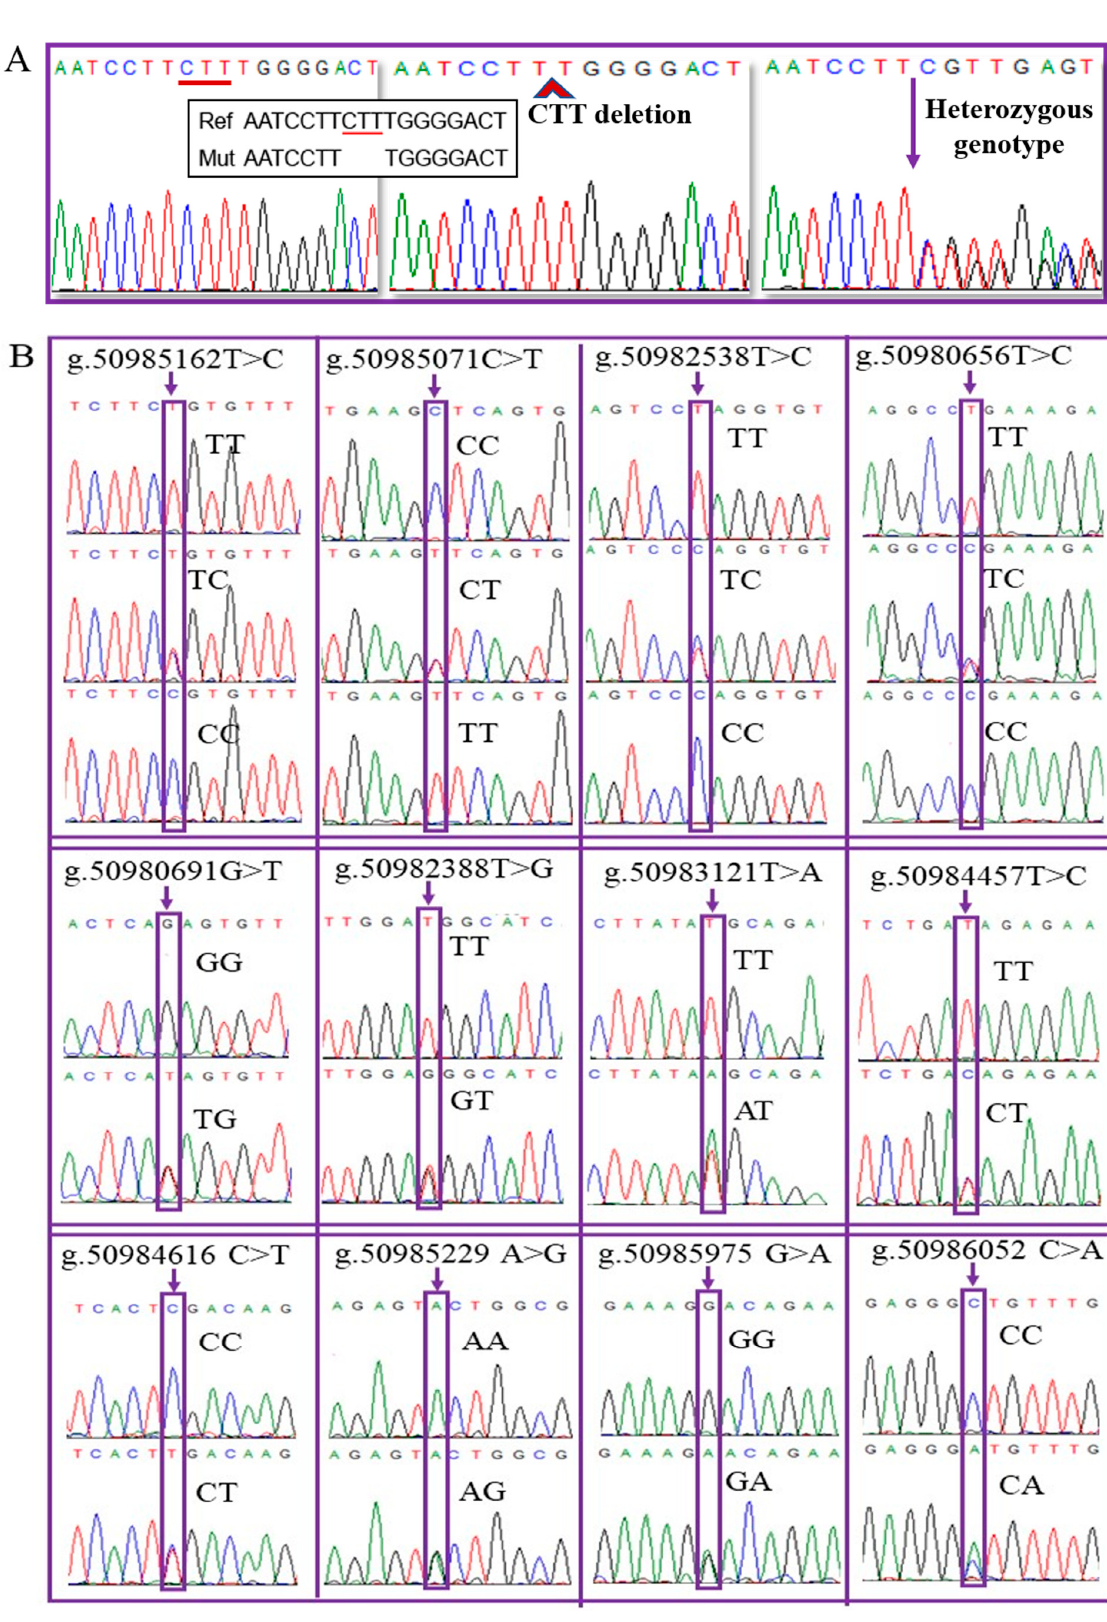
Figure 1. Sequence profiles of 13 variations in the BMP15 gene in Luzhong mutton sheep. ( A ) Sequence profile of the CTT base deletion at the ENSOART00000010201.1: c.58_60 in exon 1. ( B ) Sequence profile of the 12 base substitutions in intron 1 and exon 2.